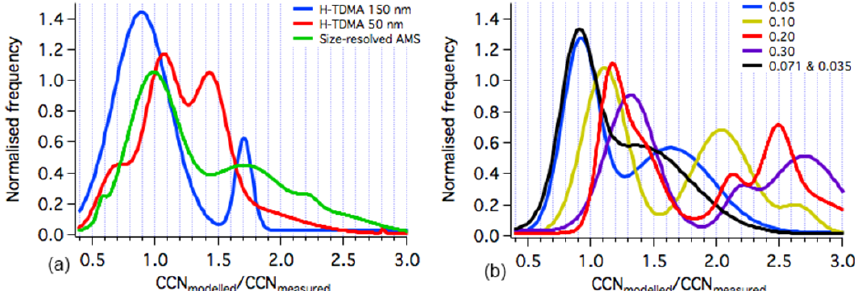
Figure 7. The normalised probability density functions for the frequency of the ratio of the modelled and measured CCN concentrations based on (a) the 150 and 50nm H-TDMA-derived hygroscopicities and size-resolved cToF-AMS composition and (b) the campaign average hygroscopicity, κ = 0 . 05; typical BB hygroscopicities of 0.1 and 0.2; the continental average hygroscopicity of 0.3; and the day and night average effective hygroscopicity values of 0.071 and 0.035,